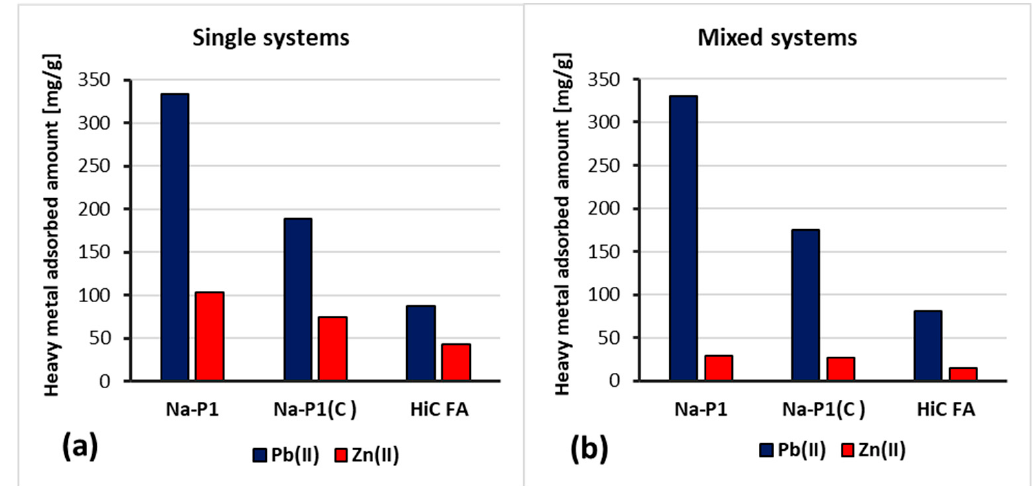
Figure 10. Amounts of Pb(II) and Zn(II) ions adsorbed on HCFA, Na ‐ P1 and Na ‐ P1(C) in the single ( a ) and mixed ( b ) systems at pH 5.